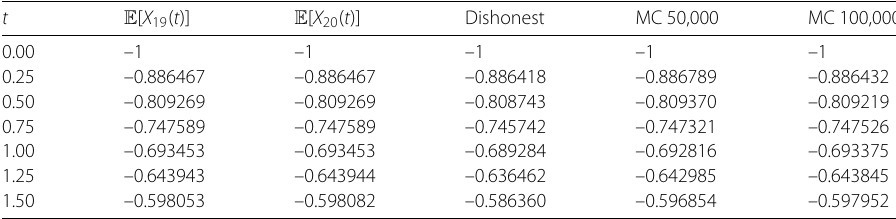
Table 10 Approximation of the expectation of the solution stochastic process. Example 4.3